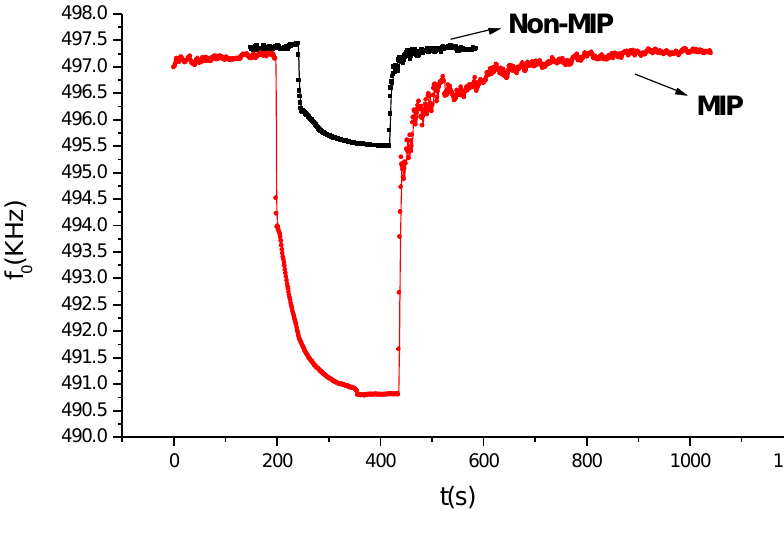
Figure 5. Confirmation of MIP effect (28 °C, RH = 70%).